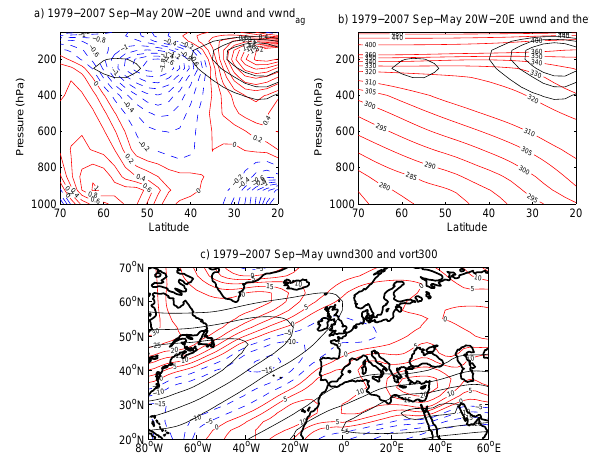
Fig. 3. September to May climatology. Meridional cross sec- tion zonally averaged between 20 ◦ W and 20 ◦ E: (a) ageostrophic meridional wind ms − 1 (positive values in red, negative values dashed in blue); (b) potential temperature (K) (red contours); the zonal wind is superimposed in black contours (5ms − 1 inter- val beginning at 15ms − 1 ) ; (c) 300hPa zonal wind ms − 1 (black contours, 5ms − 1 interval beginning at 15ms − 1 ) and vorticity (10 − 6 s − 1 ) (positive values in red, negative values dashed in